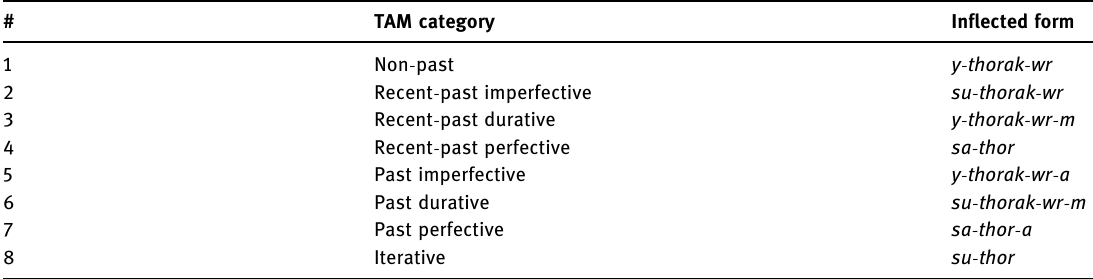
individual morphs. Consider Table 2, in which the verb thoraksi ‘ appear ’ is in fl ected for di ff erent TAM categories.¹ Table 2: thoraksi ‘ appear ’ in a 3 SG . MASC